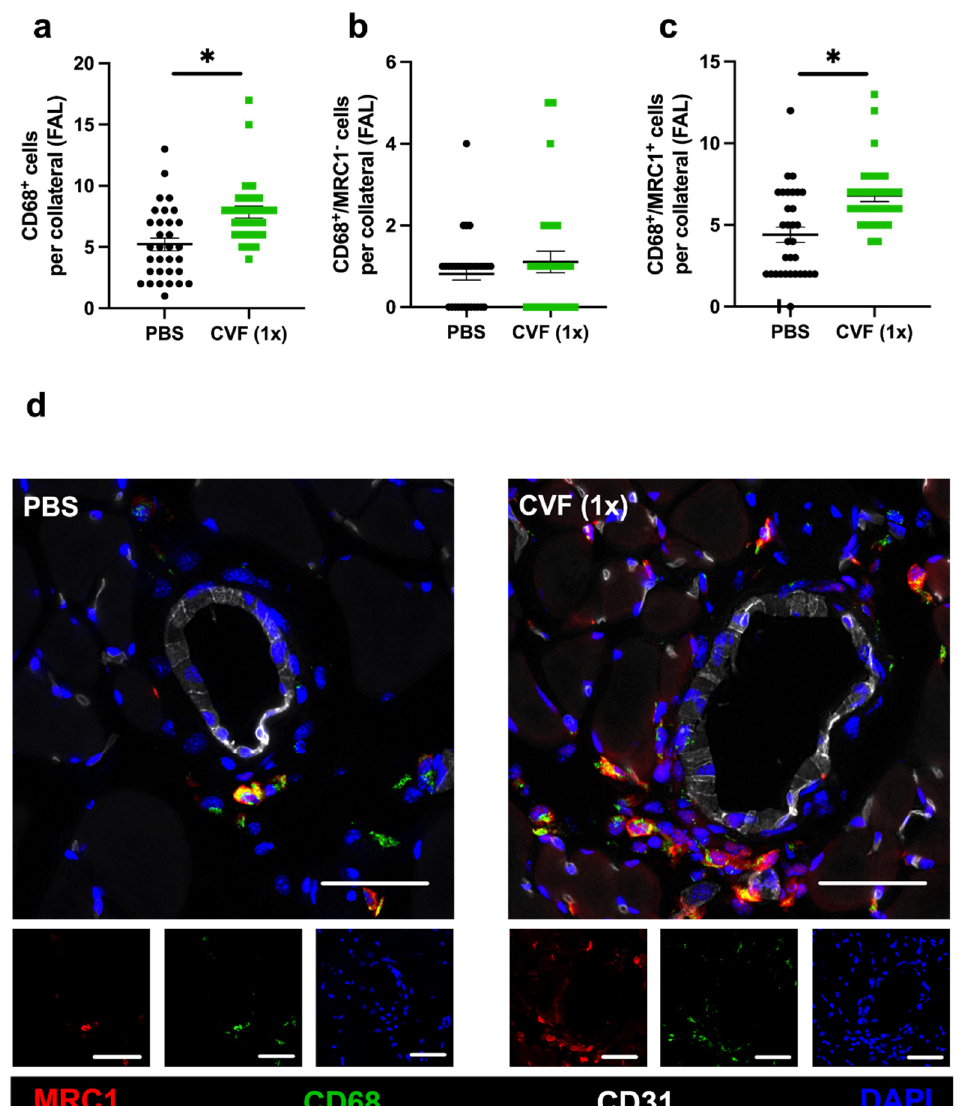
Figure 6. Single-dose cobra venom factor (CVF (1x)) application leads to an increased number of M2-like polarized macrophages per growing collateral. The scatter plots display ( a ) the number of perivascular CD68 + cells (macrophages), ( b ) the number of CD68 + /MRC1 − (mannose receptor C-type 1) cells per growing collateral, and ( c ) the number of CD68 + /MRC1 + cells per growing collateral in the adductor muscle of single-dose phosphate-buffered saline (PBS)- or CVF-treated mice collected 7 days after femoral artery ligation (FAL). Data are the means ± S.E.M., n = 5 mice per group, n > 10 values per group, * p < 0.05 (PBS vs. CVF (1x)) by the unpaired Student’s t -test. ( d ) Representative immunofluorescence images of adductor muscles of single-dose PBS- (left images) or CVF-treated (right images) mice collected 7 days after FAL are presented. Images of single and merged channels show macrophages labeled with antibodies against CD68 (green) and MRC1 (red) in the perivascular space of the collaterals. The endothelial cell marker CD31 (white) was used to depict collaterals and DAPI (blue) to label nucleic DNA; scale bar: 50 µm.